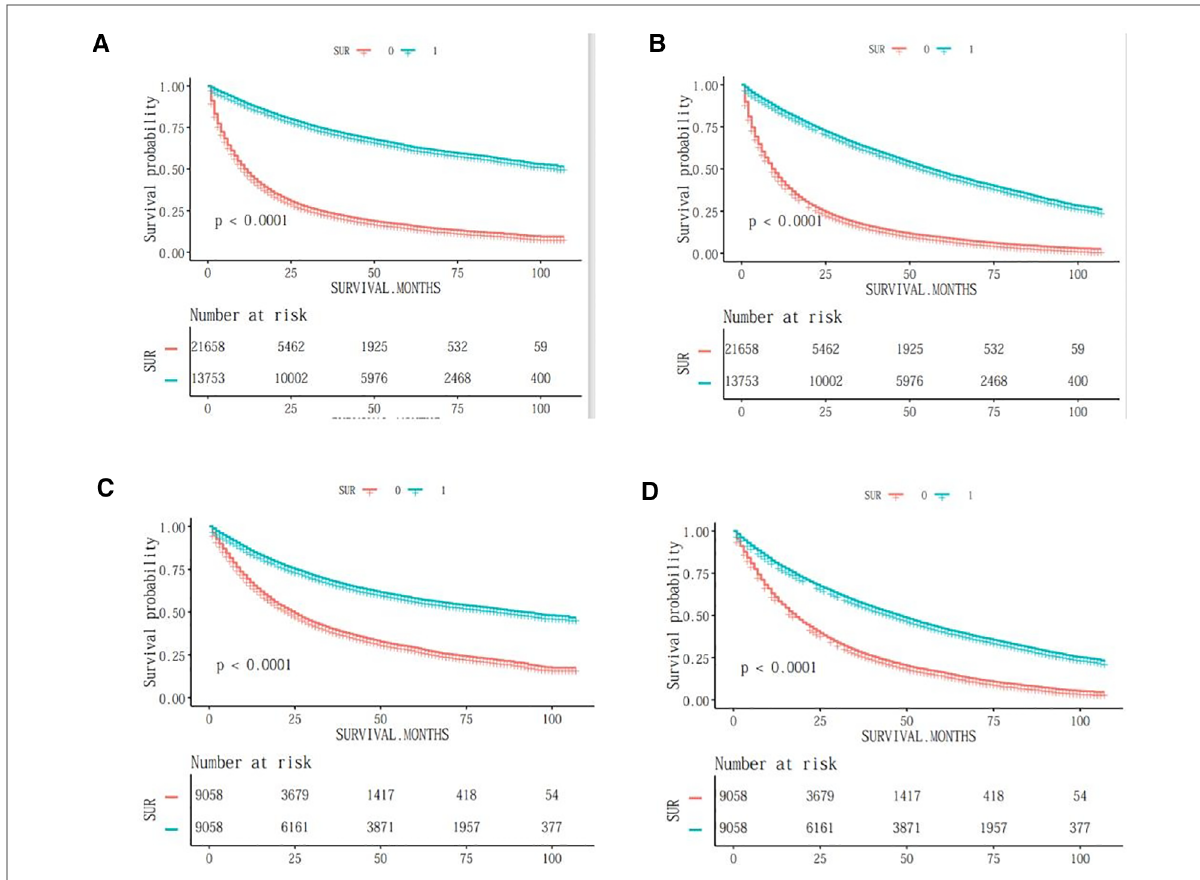
FIGURE 1 OS survival curves before and after PSM in elderly patients with NSCLC. ( A ) css-tumour-speci fi c mortality before PSM; ( B ) os-tumour overall survival before PSM; ( C ) css-tumour-speci fi c mortality after PSM; ( D ) os-tumour overall survival after